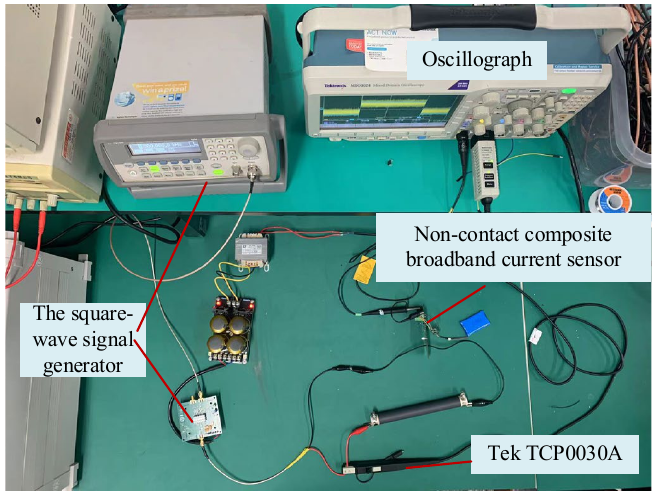
Figure 24. Experimental field diagram of the pulse current testing platform.